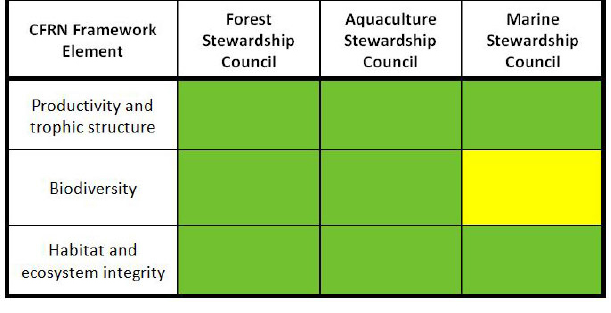
Fig. 1 . Certification criteria of three certification schemes categorized as complete (green), partial (yellow), or no (white) treatment of ecological elements of the Canadian